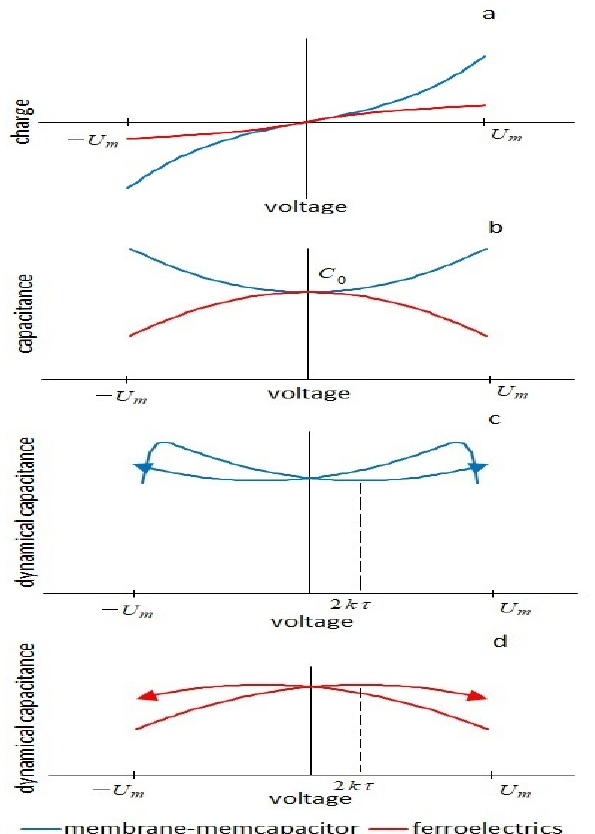
Figure 9. Characteristics of membrane-memcapacitor (blue) and ferroelectrics (red): ( a )—charge– voltage characteristics, ( b )—dependences of the nonlinear capacitance on voltage. For the membrane in the absence of viscous effects in the first quarter of the period, the capacitor is discharged, the source work is negative, in the second quarter it is charged, the source work is positive, the source work for the half-cycle is zero, and the system is neutral. For a ferroelectric in the first quarter—charging, in the second—discharging, the system is neutral. ( c )—dependence of the dynamic capacitance of the membrane (of the ferroelectric) on voltage. Due to the delay in polarization, part of the half-cycle of the triangular voltage, when the capacitor is discharged, increases; as a result, there is a negative insertion conductance. Delaying polarization with this type of nonlinearity reduces losses and results in pinched hysteresis. The system is active. ( d )—dependence of the dynamic capacitance of the ferroelectric on voltage. Due to the delay in polarization, the part of the half ‐ cycle of the triangular voltage, when the capacitor is charged, increases; as a result—there is a positive insertion